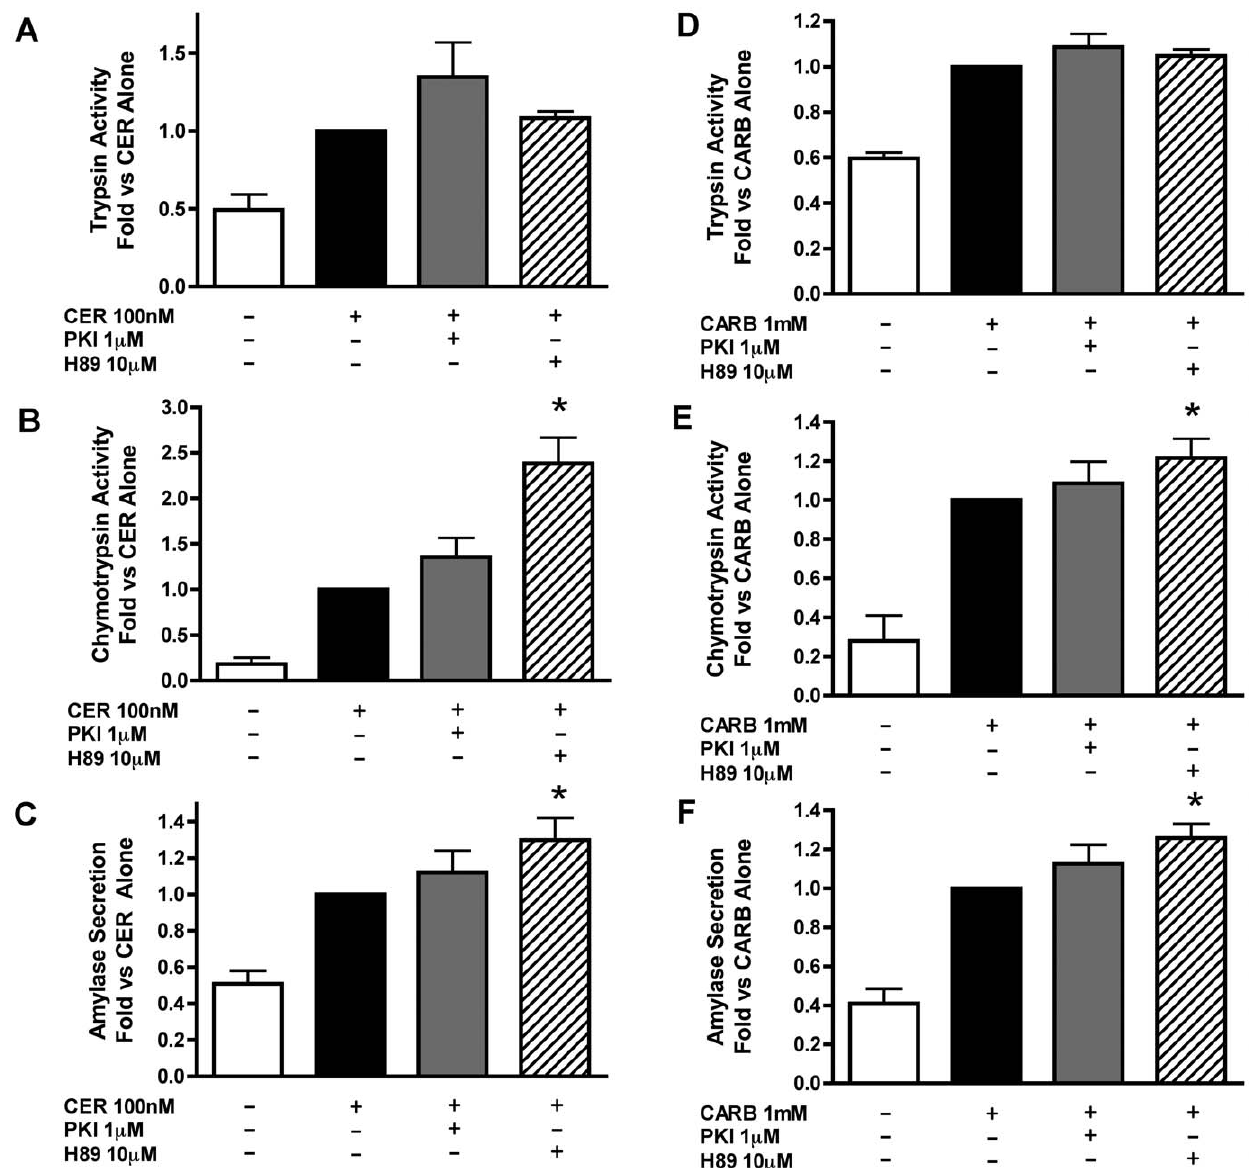
Figure 5. Inhibition of PKA enhances secretagogue stimulated zymogen activation and amylase secretion. Acini were treated with or without the PKA inhibitor PKI [1 m M] or H89 [10 m M] for 60 min prior to the addition of either CER [100 nM] or CARB [1 mM]. Cells were assayed after one hour of secretagogue treatment for trypsinogen activation (A,D), chymotrypsinogen activation (B,E) and amylase secretion (C,F). *p , 0.05 vs. corresponding CER or CARB treatment alone (n $ 5).